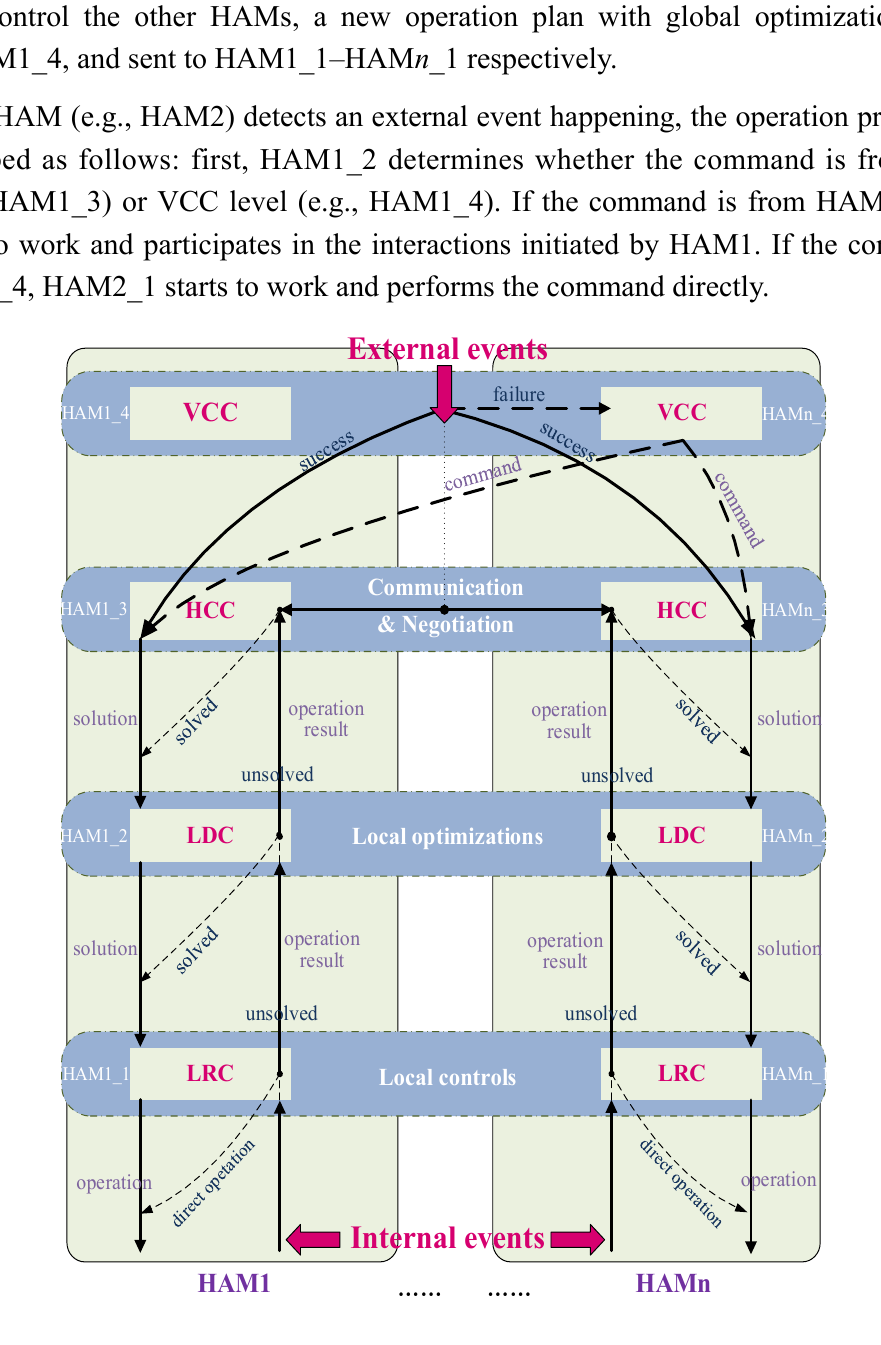
Figure 2. Operating rules of